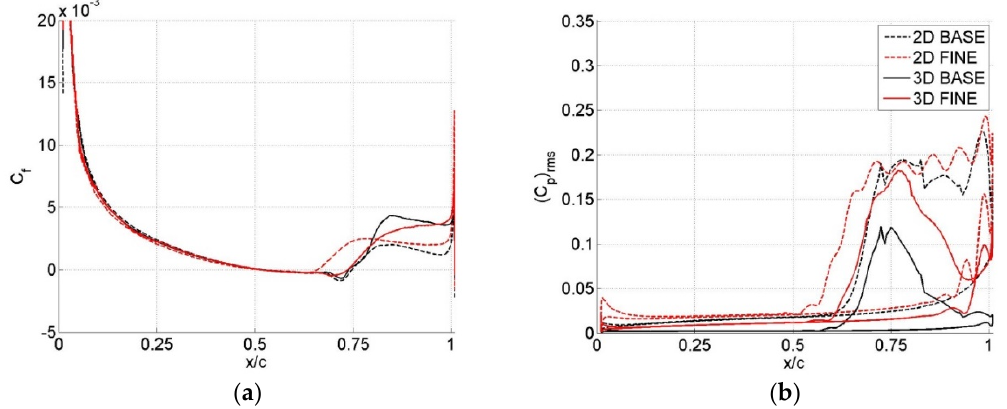
Figure 17. ( a ) Skin friction coefficient on suction sides. ( b ) Suction-side airfoil surface RMS pressure distribution. NACA- 0012 at 2° AoA, U = 25 m/s. (Adapted from [41]).